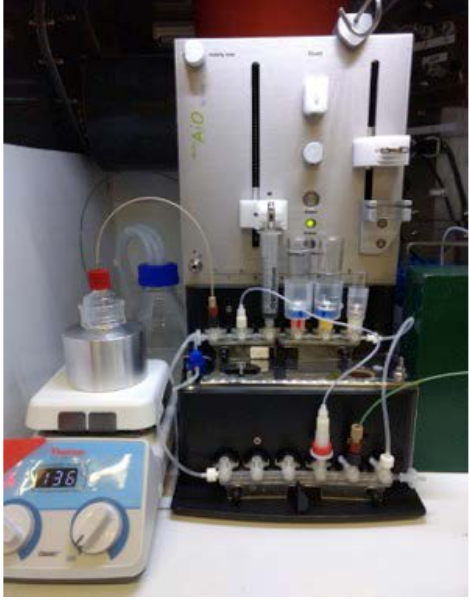
Figure 1. TRASIS mini AlliOne (miniAiO) setup for purification of zirconium-89.